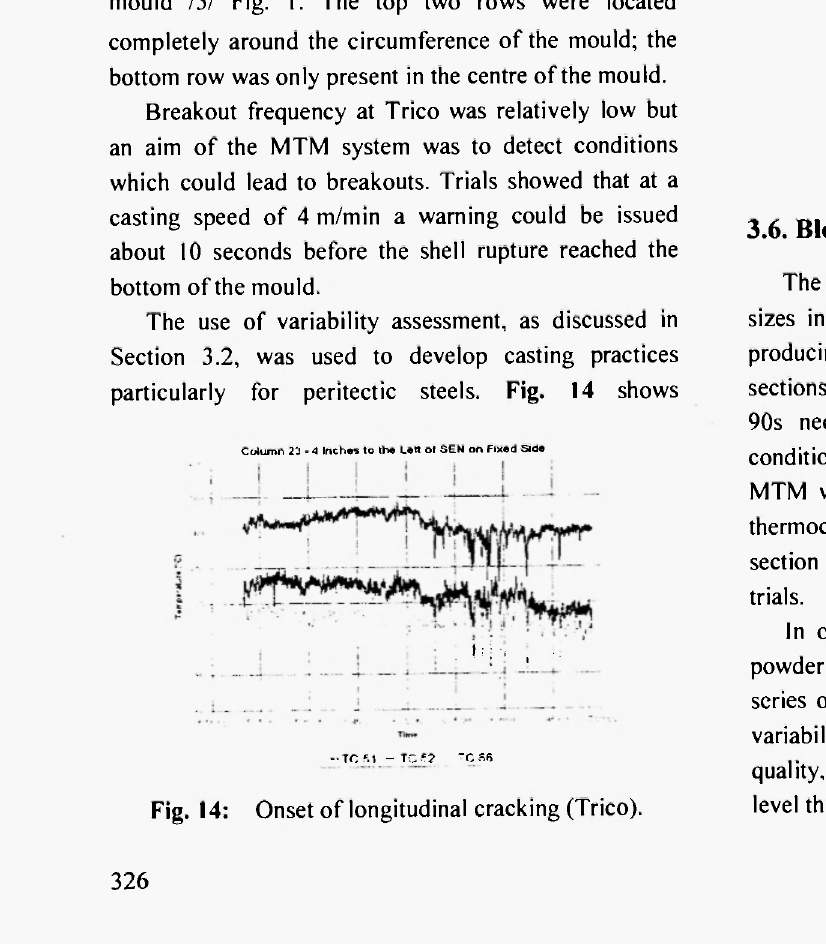
Fig. 15: Cut in EMBr power